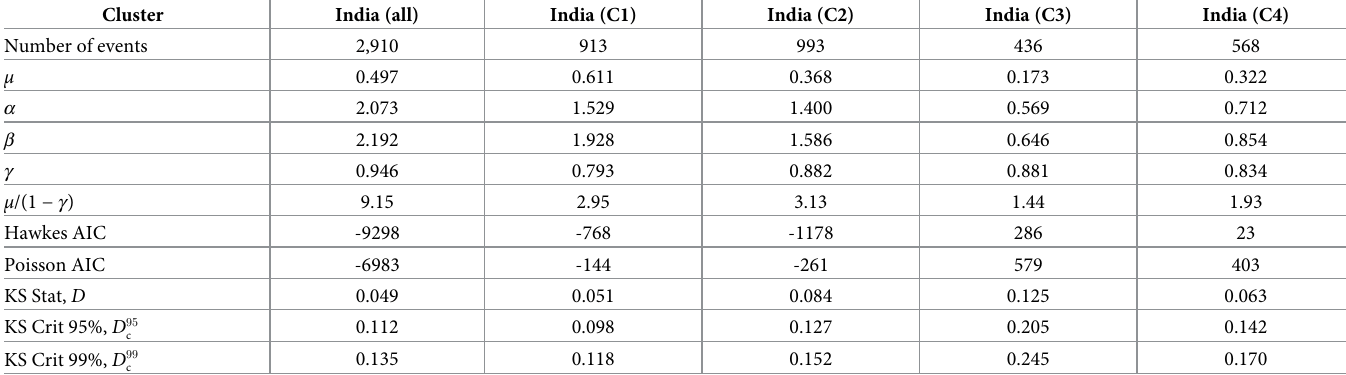
Table 2. Statistical outcomes of the Hawkes process applied to data from India. The Hawkes process outperforms the baseline Poisson process both nationwide and in each cluster, since the Hawkes AIC is always less than the Poisson AIC. The Hawkes process passes the KS test at the 95% significance level in all cases, with D < D 95